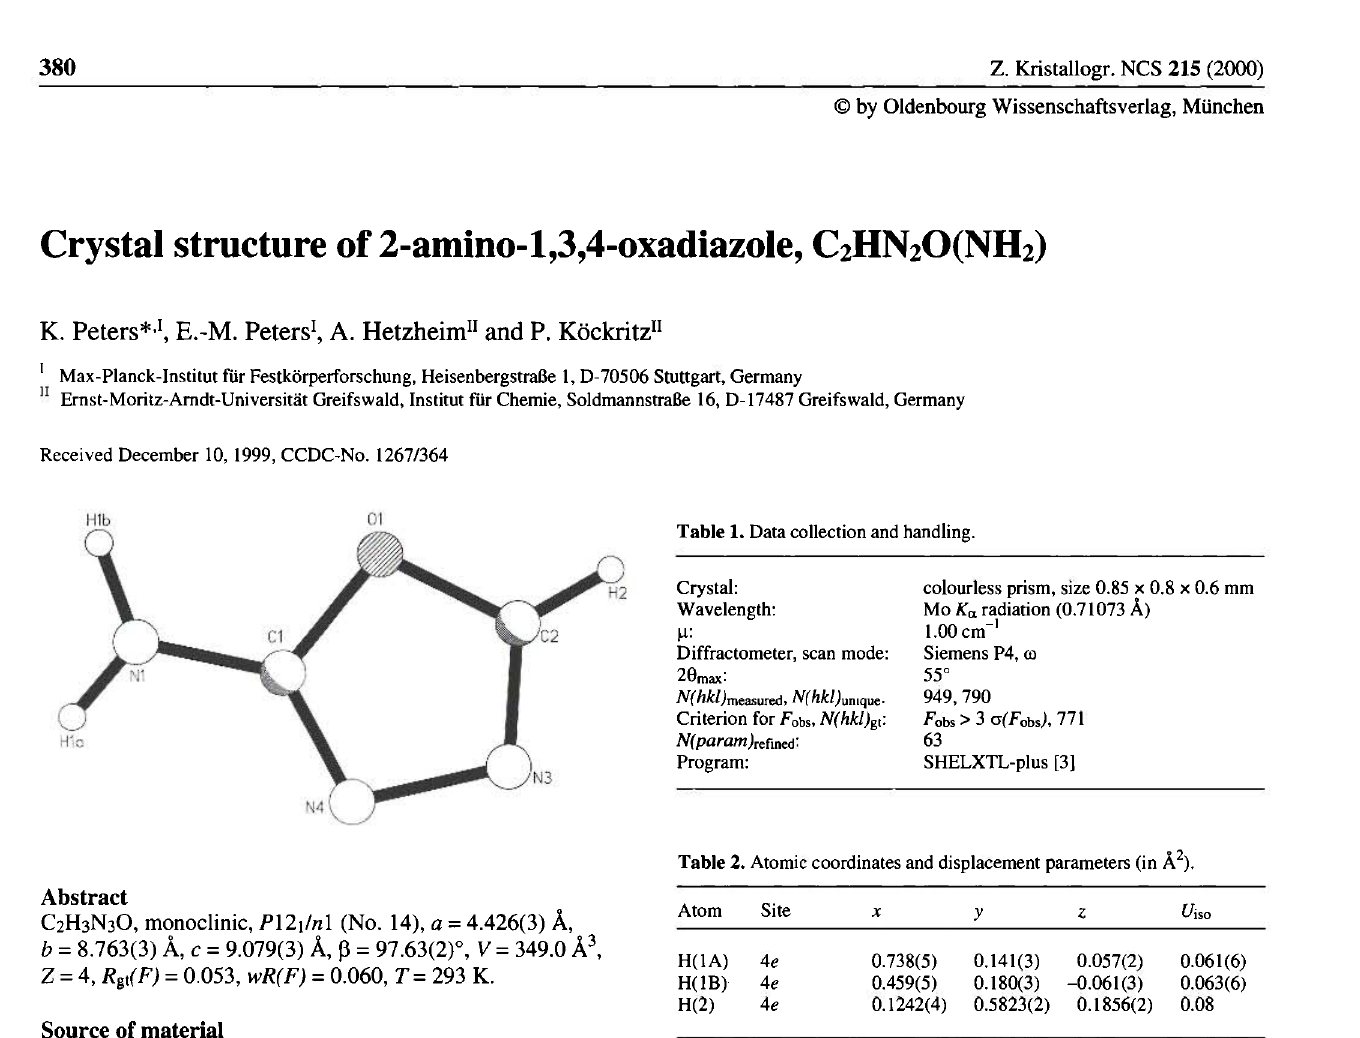
Table 2. Atomic coordinates and displacement parameters (in Ä 2